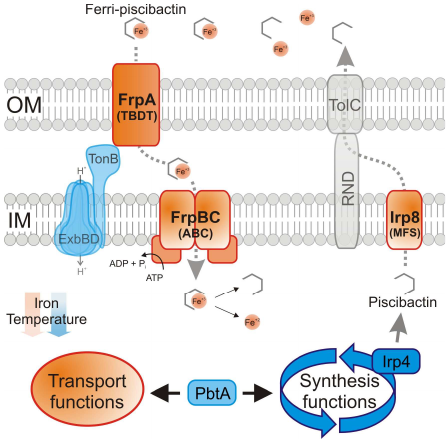
Figure 8. A model of production and utilization of piscibactin in V. anguillarum . Piscibactin genes are induced when V. anguillarum grows under low-iron conditions at cold temperature. The tran- scriptional activator PbtA is required to express both biosynthesis and transport functions. During synthesis, the thioesterase Irp4 early releases nascent piscibactin from the NRPS/PKS enzyme line. After synthesis, piscibactin is exported to the extracellular space through the MFS protein Irp8. RND proteins and the outer membrane channel TolC would likely participate in the secretion process. Once the ferri-piscibactin complex is formed in the external medium, it would be internalized to the cyto- plasm through the outer membrane TBDT FrpA and ABC transporter FrpBC. Final iron release from the ferri-piscibactin complex and its further incorporation to the cell metabolism is accomplished in the cytoplasm. OM, outer membrane; IM, inner membrane; RND, resistance-nodulation-cell division protein; TBDT, TonB-dependent transporter; ABC, ATP-binding cassette